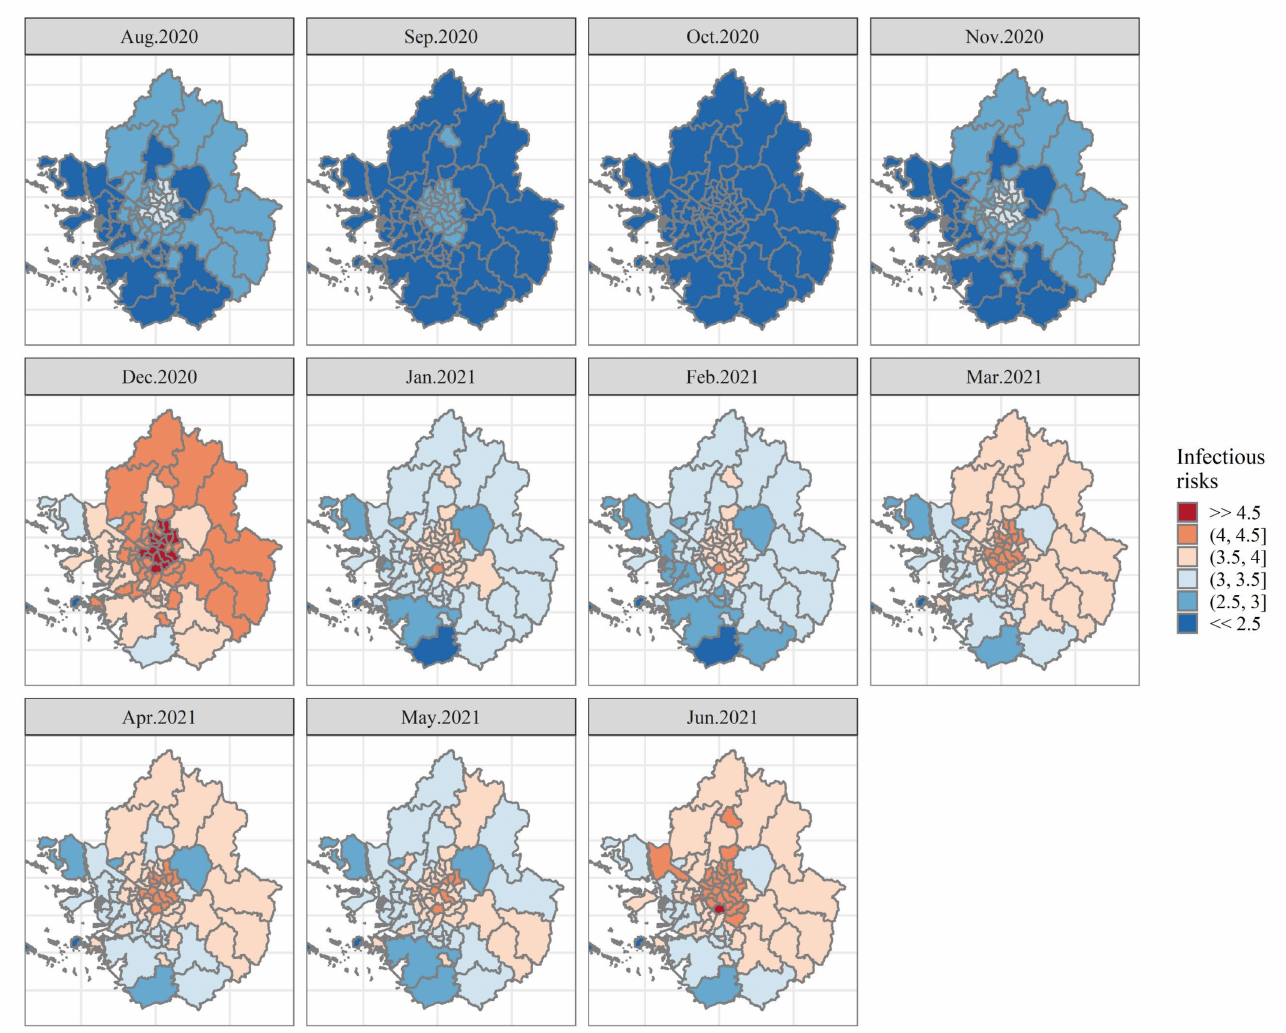
Figure 6. Spatiotemporal diffusion risks of COVID-19 during the second and third waves of the